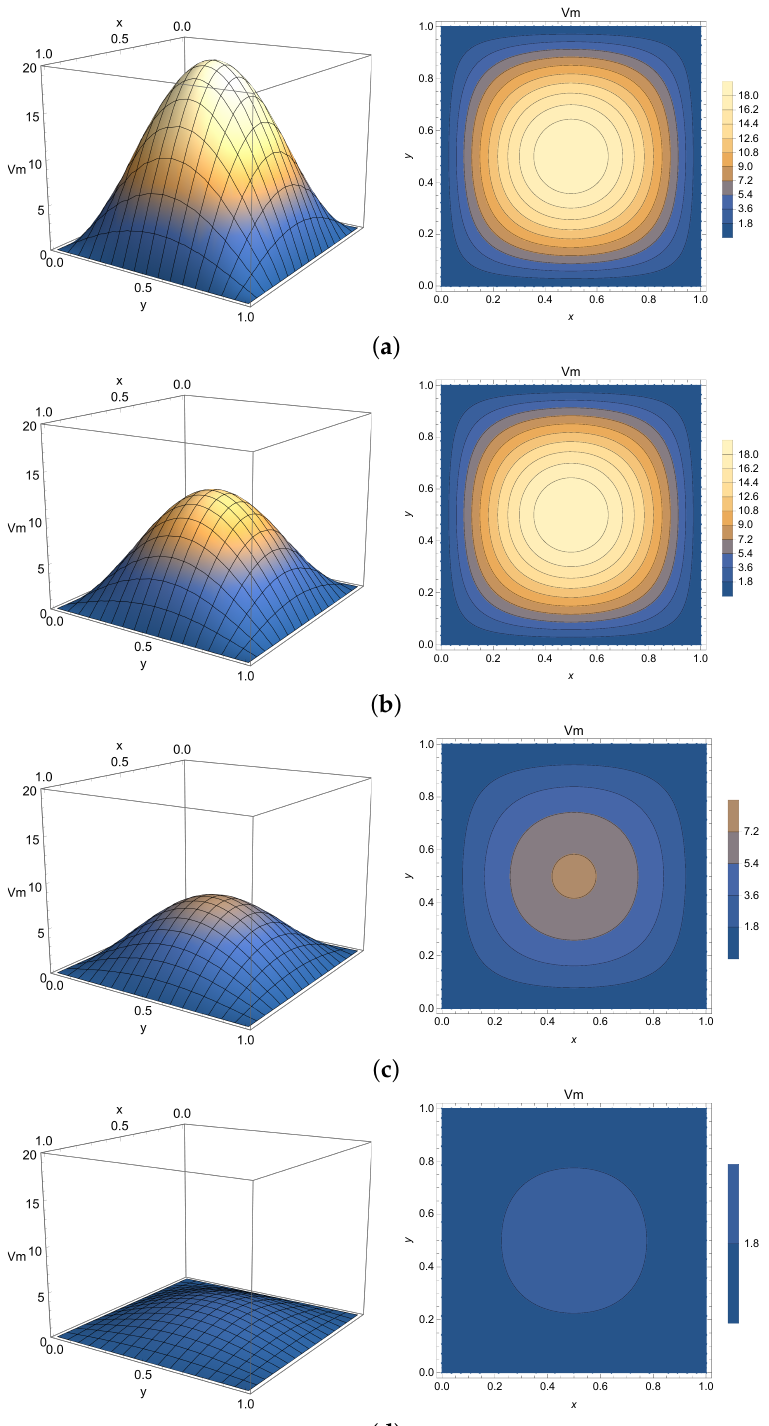
Figure 8. Two-dimensional homogeneous solution describing the potential plateau after depolar- ization: Equation (27) with α = 1 (integer order case). ( a ) t = 0 µ s, ( b ) t = 250 µ s, ( c ) t = 500 µ s, ( d ) t = 1000 µ